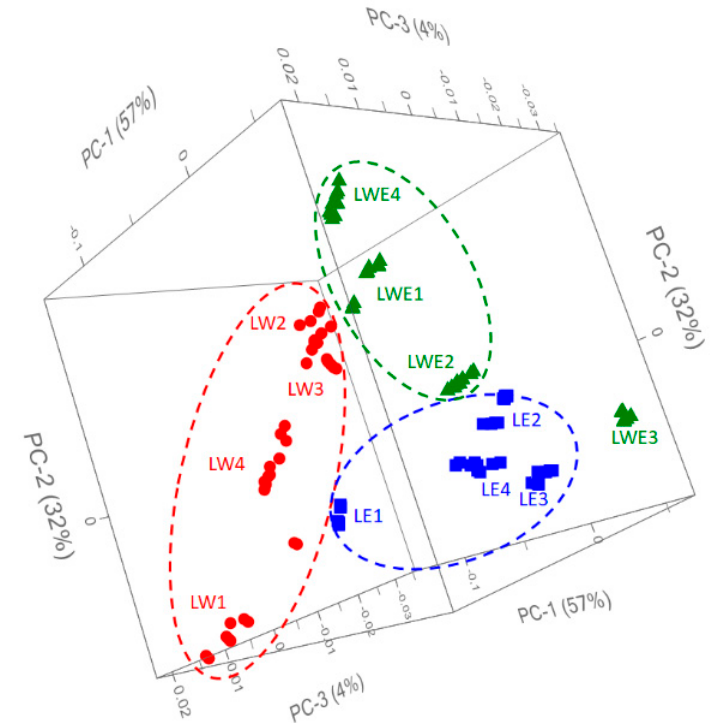
Figure 3. Three-dimensional score plot PC1-3 obtained by the PCA modeling of FTIR data from Nocera Rosso L1, Magliocco Rosato L2, Magliocco Canino L3, and Gaglioppo L4 extracts in the range 1850–450 cm − 1 with a total explained variance of